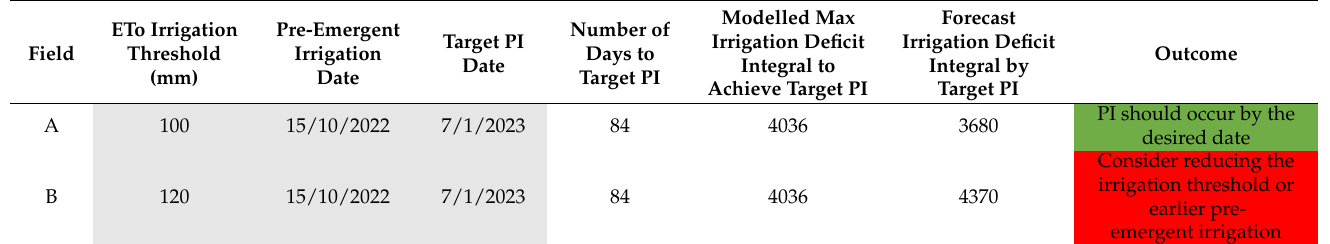
Table 3. Input data required from growers (grey) for the decision support tool with positive outcomes displayed in green and negative outcomes in